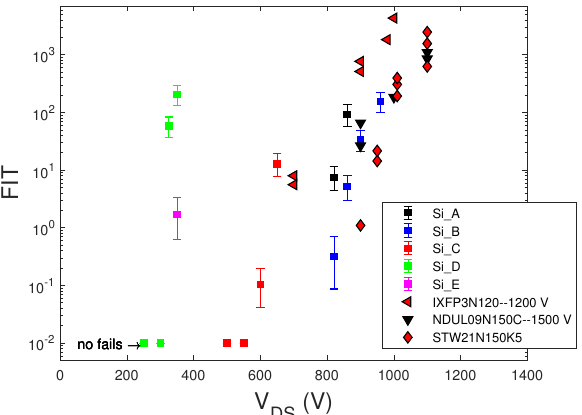
Figure 6. FIT data at sea level of the STMicroelectronics Si MOSFETs ( (cid:3) ). Data of the commercial Si MOSFETs IXFP3N120–1200 V (Ixys), NDUL09N150C -1200 V (ONSEMI), and STW21N150K5-1500 V (STMicroelectronics) from